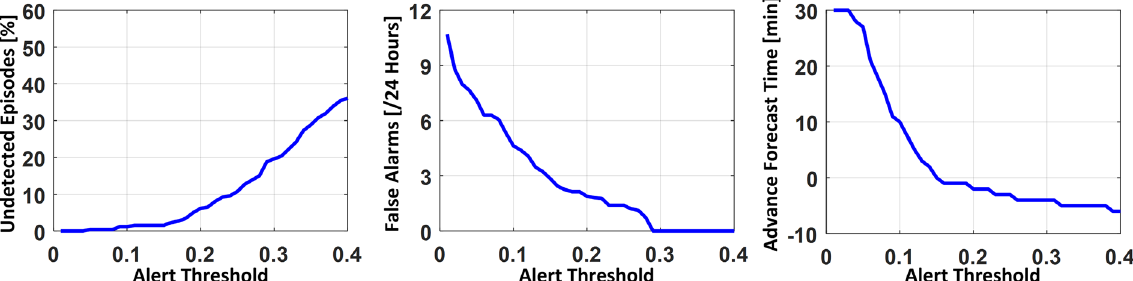
Figure 2. Relationship between diagnostic performance metrics versus alarm thresholds for the logistic regression model output. With increasing output threshold (i.e., a more stringent threshold for alarming), the model exhibited i ) increasing rate of undetected episodes of hypotension; ii ) decreasing false alarm rate; and iii ) decreasing advance forecast time.